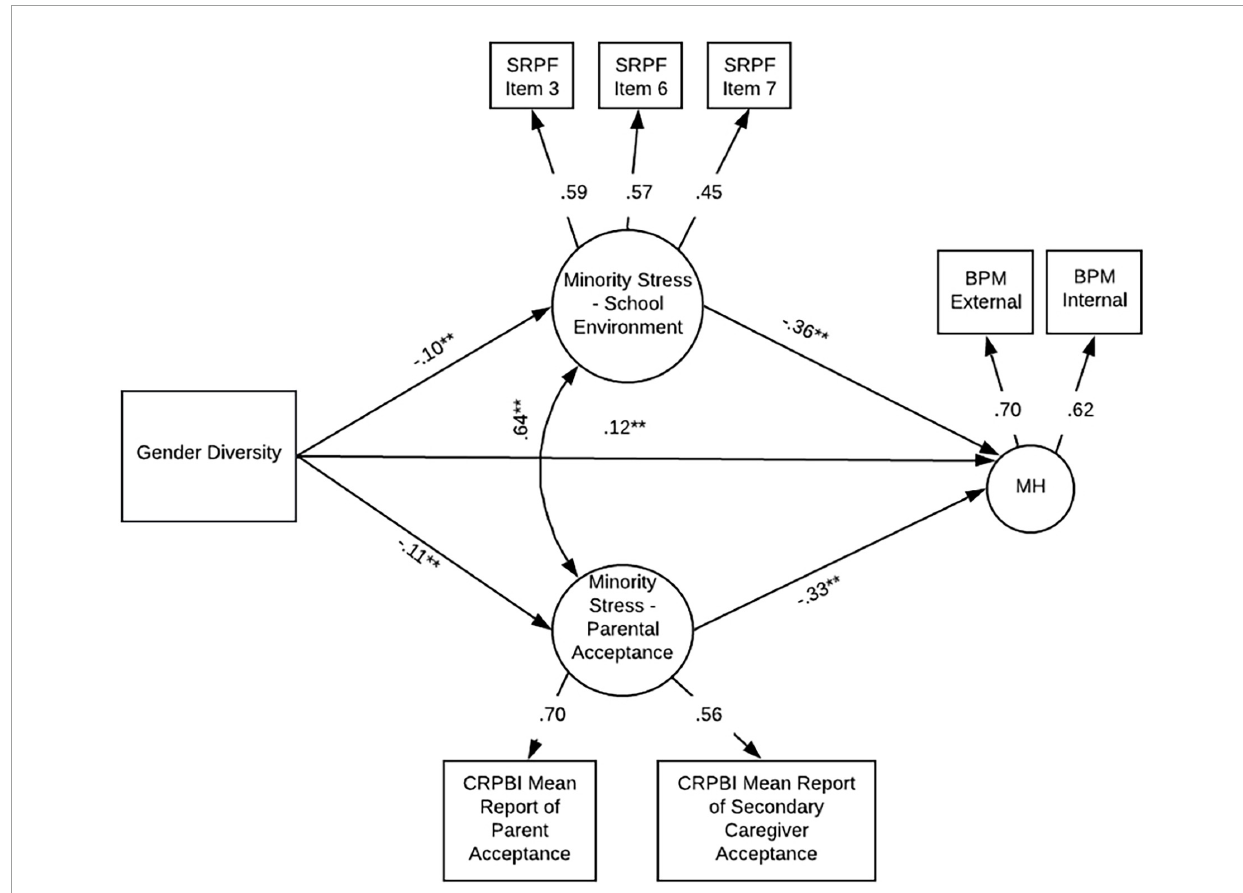
FIGURE5 Final model. SRPF, school risk and protective factors; Item 3 = “I get along with my teachers”; Item 6 = “I feel safe at my school”; Item 7 = “The school lets my parents know when I’ve done something well”; BPM, brief problem monitor (ASEBA brief problem monitor—youth form for ages 11–18); CRPBI, children’s report of parent behavior inventory; MH, mental health. ** p <